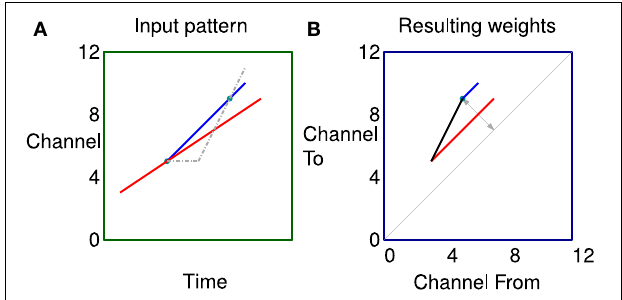
FIGURE 7 | Correlations in a more complex stimulus. (A) Stimulus consisting of two rising tones, the two dots are in exactly the same position as Figure 6 for comparison. (B) The network can learn the fact that there are two sweep velocities present at the same time as indicated by the colors. Because the sweeps are linear the potentiated synapses representing the individual sweeps (red and blue) are parallel to the diagonal in the weight matrix. The black synapses are potentiated by the apparent “up” velocities between pairs of points of different colors as they diverge.